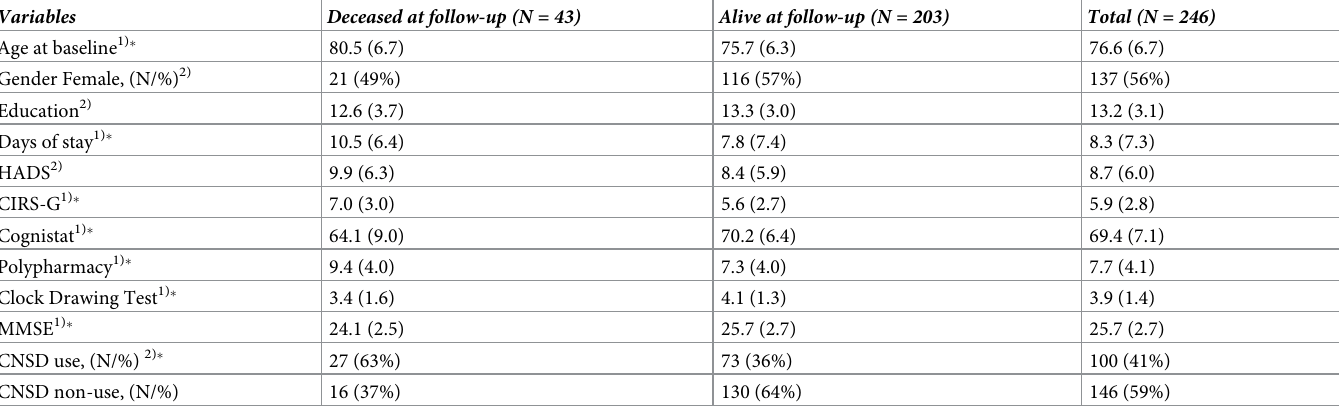
Table 1. Baseline characteristics stratified for alive and deceased patients at two year follow-up.